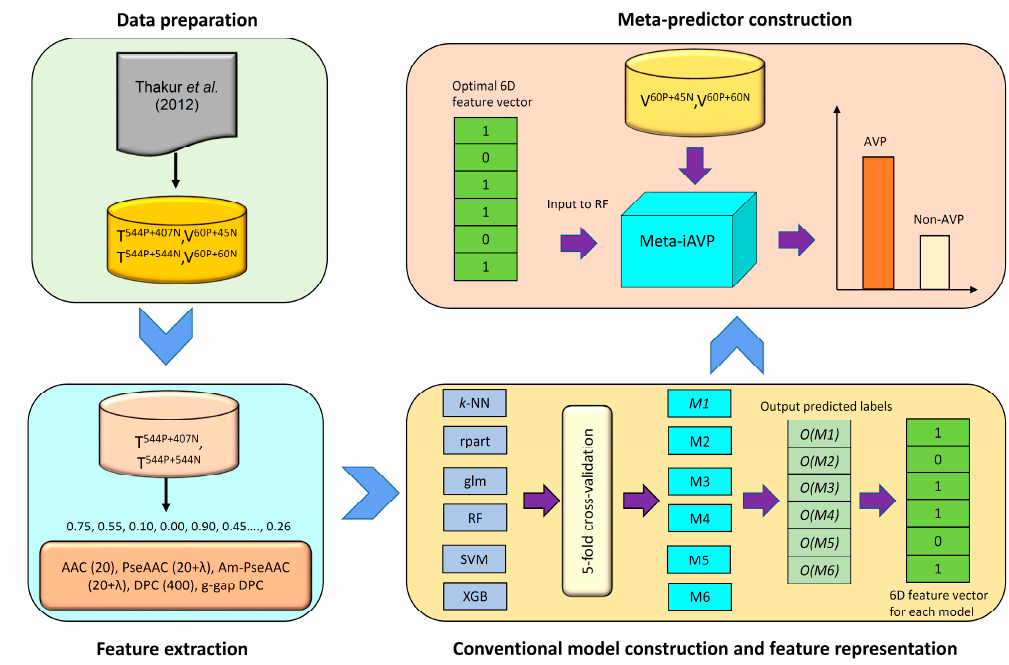
Figure 2. Schematic framework of Meta-iAVP. Overview of the proposed methodology for discriminating AVPs from Non-AVPs involving the following steps: (1) preparing two benchmark datasets; (2) extracting a peptide sequence with five types of features to encode six models; (3) constructing six ML models to generate a six-dimentional feature for each type of feature O(M), where 1 and 0 are represented with AVPs and Non-AVPs, respectively; and (4) establishing the meta-predictor for each benchmark dataset that separates a query peptide into AVPs and Non-AVPs.